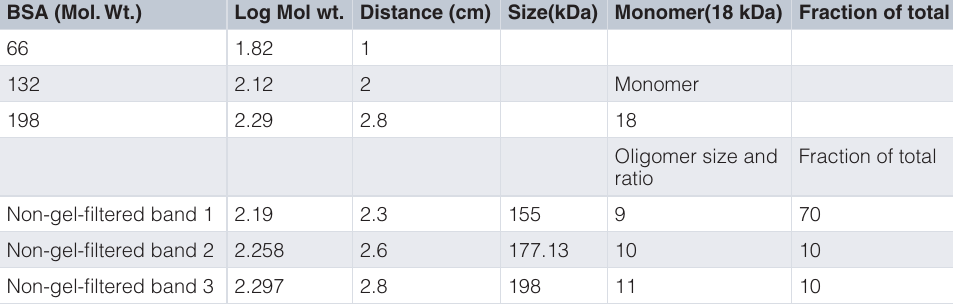
Table 1. Oligomer ratio calculation. The Native-PAGE data was used to calculate the oligomeric sizes and ratios of different bands in non-gel-filtered and gel-filtered samples. Oligomer sizes were calculated using bovine serum albumin (BSA) monomers, dimers and trimers as a reference (66, 132 and 198 kDa) and the log of molecular weights plotted versus the distances travelled in centimetre. From this calculation, molecular weight was extrapolated for the different bands seen in non-gel-filtered samples (band 1, 2, 3, 4) and gel-filtered samples (band 1, 2, 3, 4 and 5). BSA (Mol.